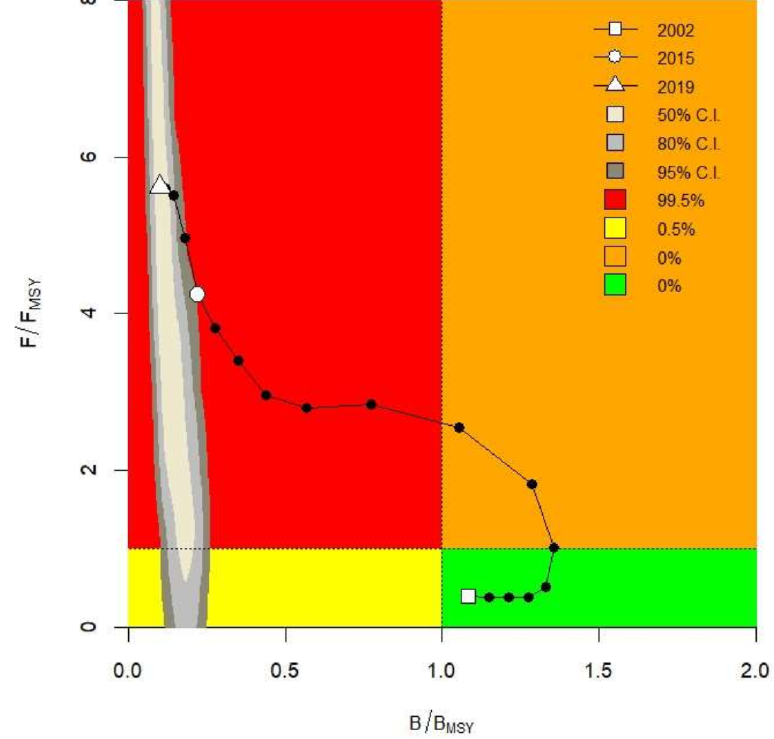
Figure 4. Kobe plot of BSM for the Indian salmon fishery in the BoB, Bangladesh